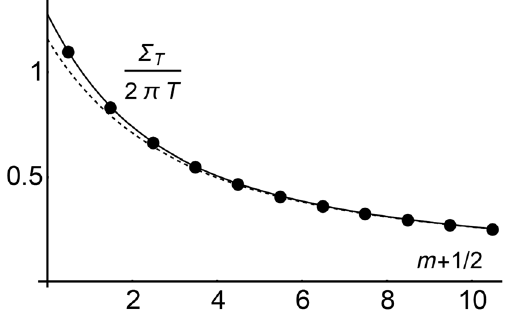
ð ω Þ to the fermionic self- FIG. 3. The thermal contribution Σ T m energy. The black dots are a numerical solution of Eq. (25). The dashed line is the analytic approximation in Eq. (27), and the solid black line is a solution with higher accuracy, up to log log log ð(cid:2) (cid:2) (cid:2)Þ terms. The numerical solution was obtained for ð 2 π T=v M Þ ¼ ð ¯ g= 2 π T Þ ¼ 10 F